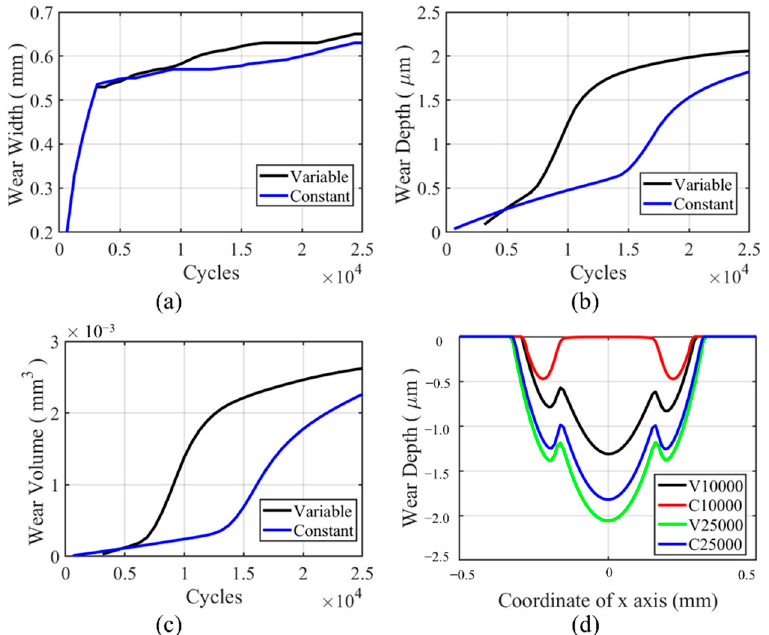
Figure 25. History and profile of wear characteristics for the cylindrical pad in the partial slip regime for both CWCM and VWCM: ( a – c ) are the history of wear characteristics, and ( d ) is the wear profiles after the 10,000th and 25,000th cycle.